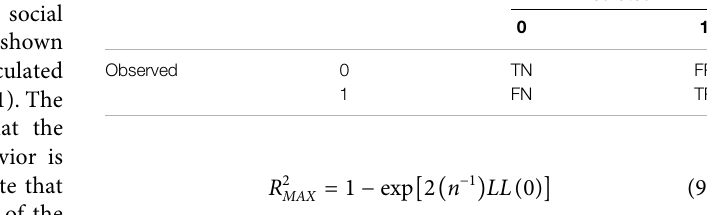
TABLE 2 | Binary classi fi er outcomes.